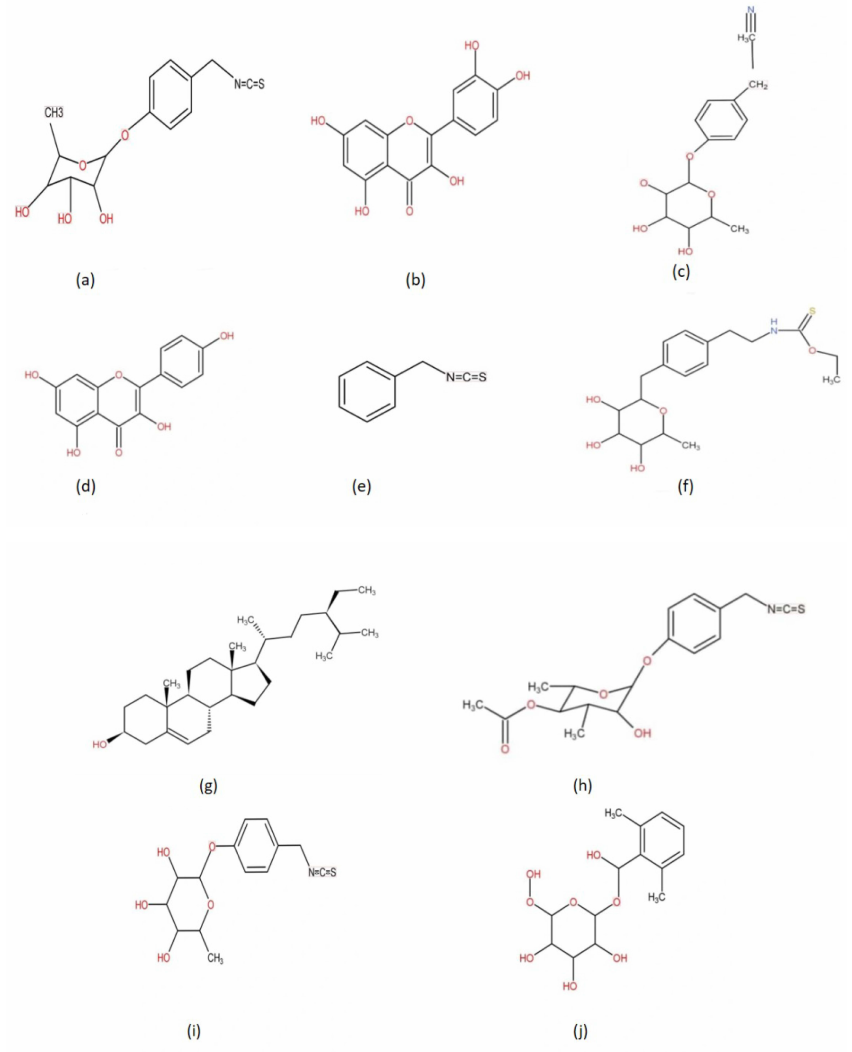
Figure 1. Selected bioactive compounds from Moringa oleifera: ( a ) 4-(-L-rhamnopyranosyloxy) benzlisothiocyanate, ( b ) Quercetin, ( c ) Niazirin, ( d ) Kaempferol, ( e ) Benzyl isothiocyanate, ( f ) Niazimisin, ( g ) β -sitosterol, ( h ) 4-(4-O-acetyl-a-L-rhamnosyloxy) benzyl isothiocyanate, ( i ) 4-( α -l-rhamnopyranosyloxy) benzyl isothiocyanate, ( j ) Moringine.